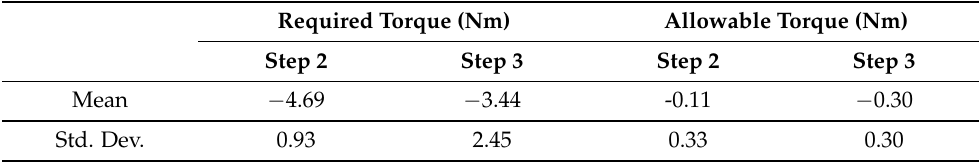
Table 4. Statistical analysis of variation in difference of required and allowable torque on front wheels during controlled and uncontrolled conditions with an active rear wheel and with respect to change in height of